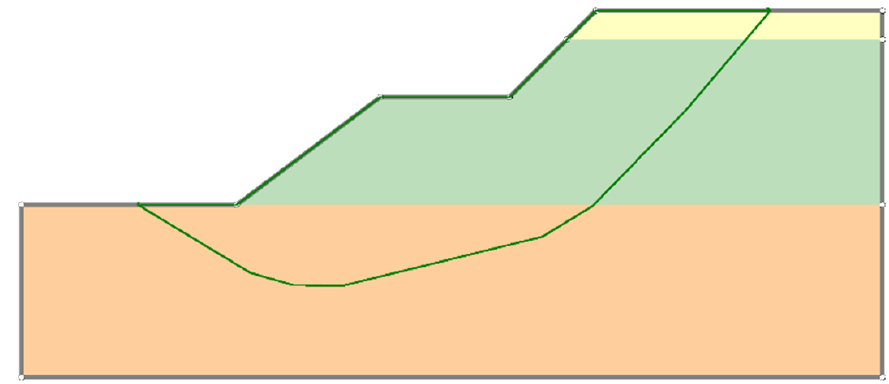
Figure 10. The critical slip surface of Spencer.